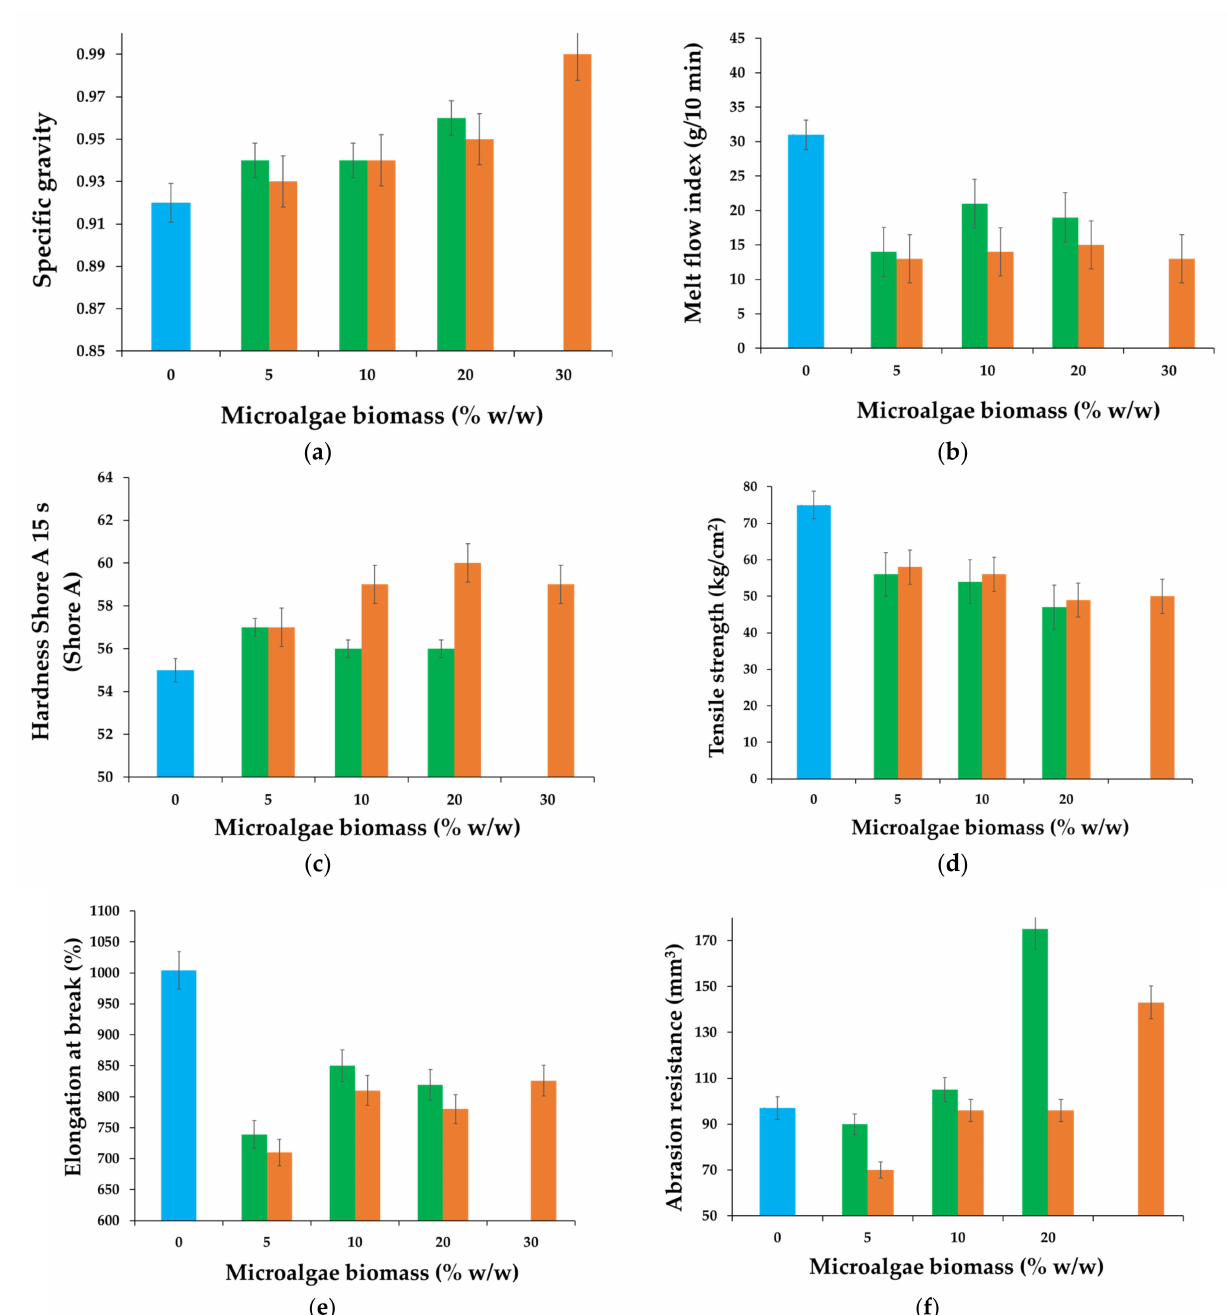
Figure 6. Physicomechanical test results for polymer composites with Chlorella biomass (green bar) and with Spirulina biomass (orange bar), and the control sample–copolymer matrix (blue bar): ( a ) specific gravity, ( b ) melt flow index, ( c ) Hardness Shore A, ( d ) tensile strength, ( e ) elongation at break, and ( f ) abrasion